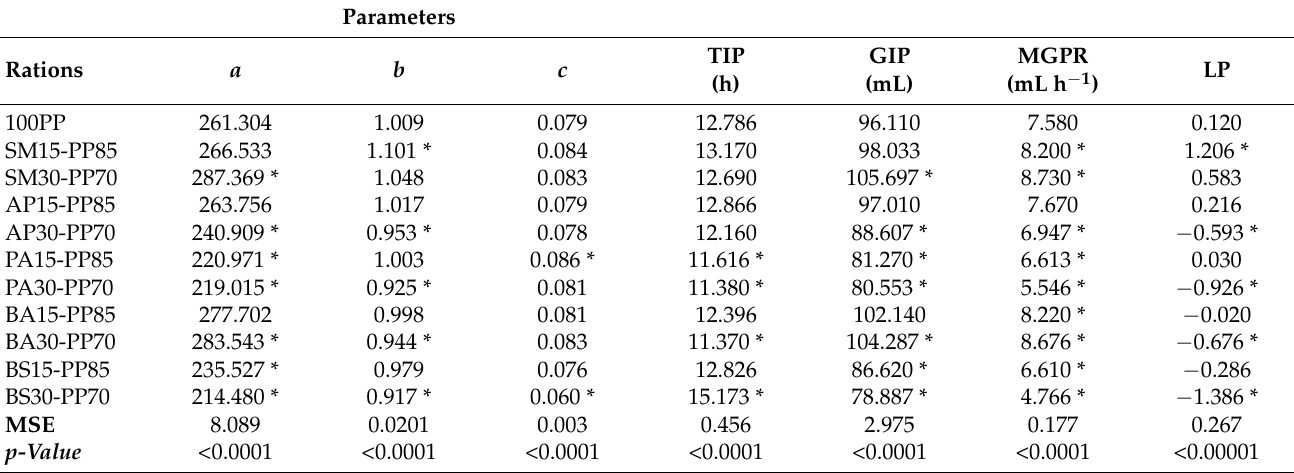
Table 3. Gompertz model parameters for in vitro gas production of forage species incorporated at two levels mixed with P. purpureum